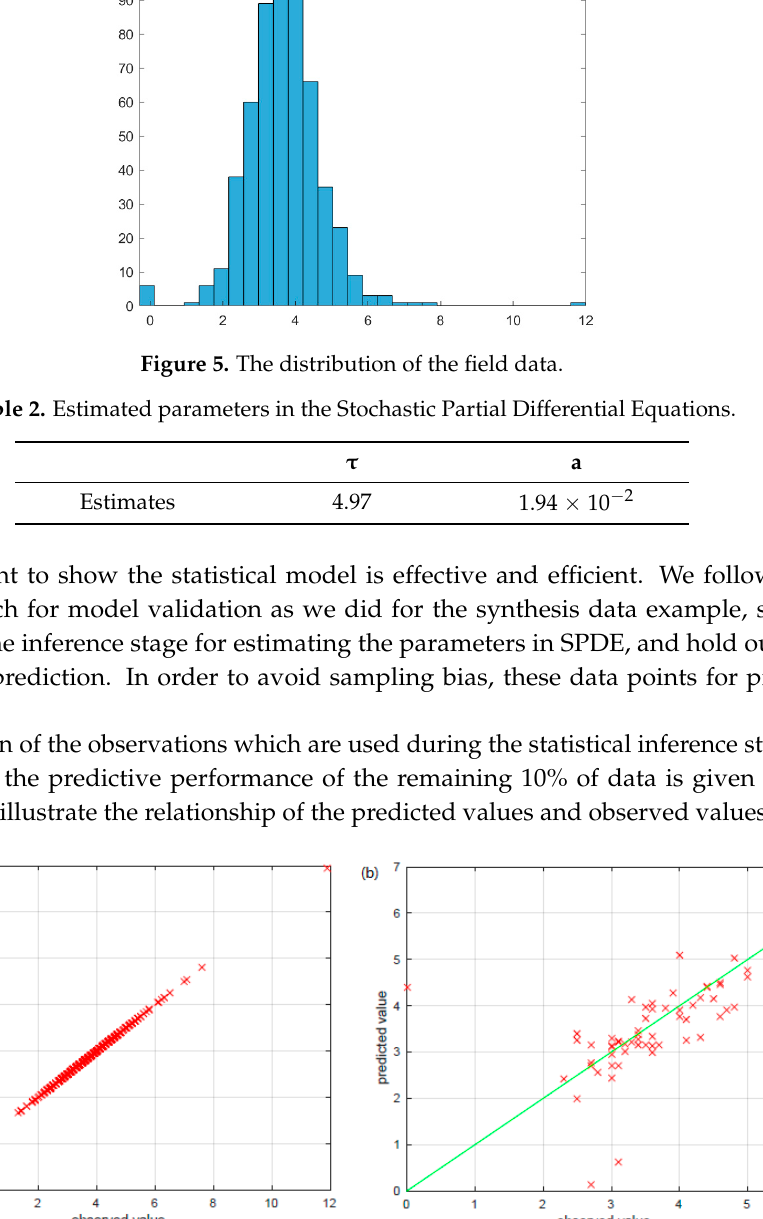
Figure 7. The SPDE prediction contour map of induced polarization data. The red and black symbols are the logging well with and without gold mine, respectively. We mark three anomaly zones. Here, we take the IP1 anomaly zone as the example. The IP 1 anomaly zone location is fixed to the geological structure zone, which is presumed to be caused by the near-east-direction fault. The reason for the IP 1 anomaly zone is due to the carbonaceous rocks and metal sulfides around the fracture zone. Based on the regional situation of the ore field, the ore-control structure is the near-east–west direction. The shallow buried area is mainly quartz vein type gold deposit and fracture zone type gold deposit. Because the gold deposit is related to the carbonaceous material, metal sulfide, solicitation, etc., the IP 1 anomaly zone is of interest in future exploration work. We have drilled several wells for this exploration. In Figure 6, the red symbols are the wells with gold mines, such as ZK32601, ZK30401, ZK30403, ZK30701, and ZK30706. The blacks have not discovered the gold, which are ZK30802 and ZK30804.